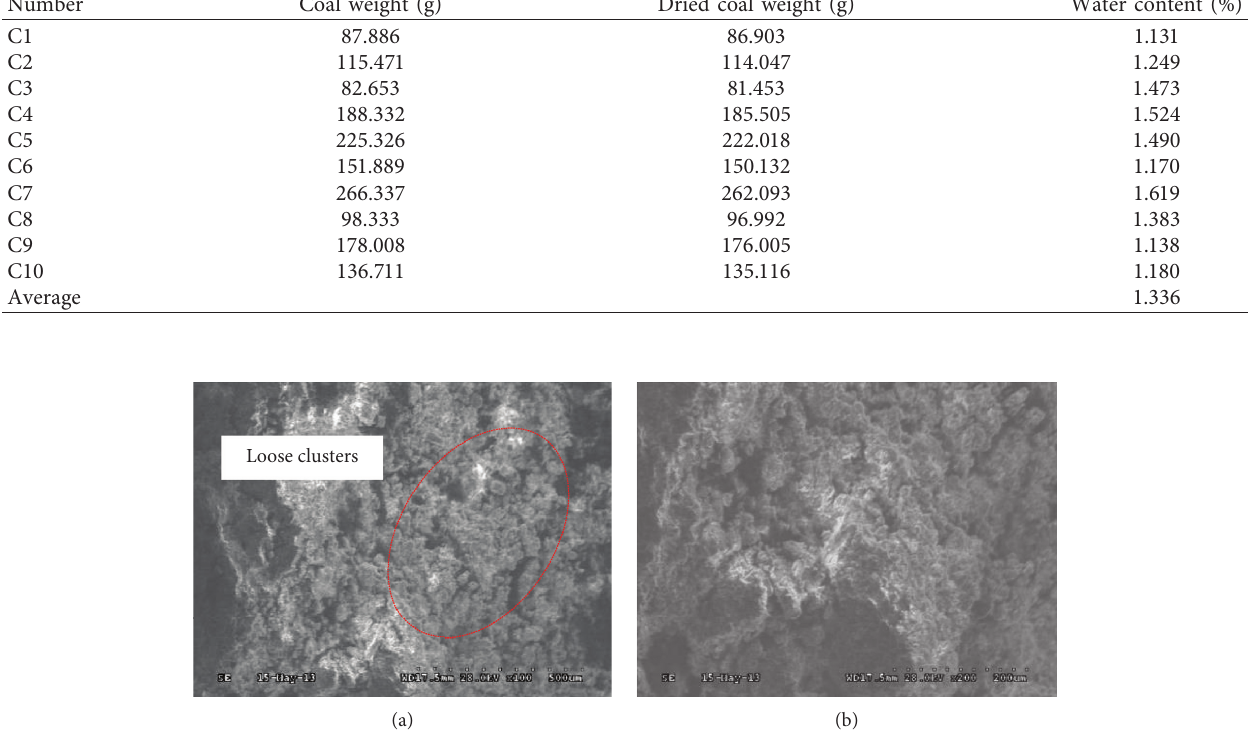
Figure 6: SEM picture of coal body: (a) 100 times; (b) 200 times.